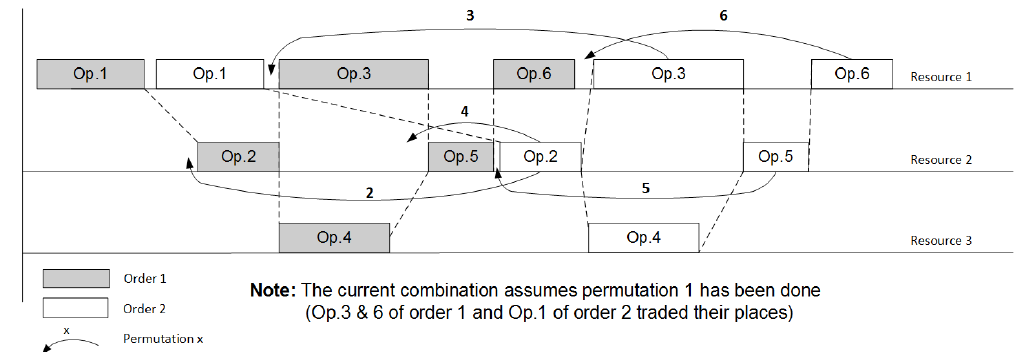
Figure 4. Permutations of competing operations in gradient